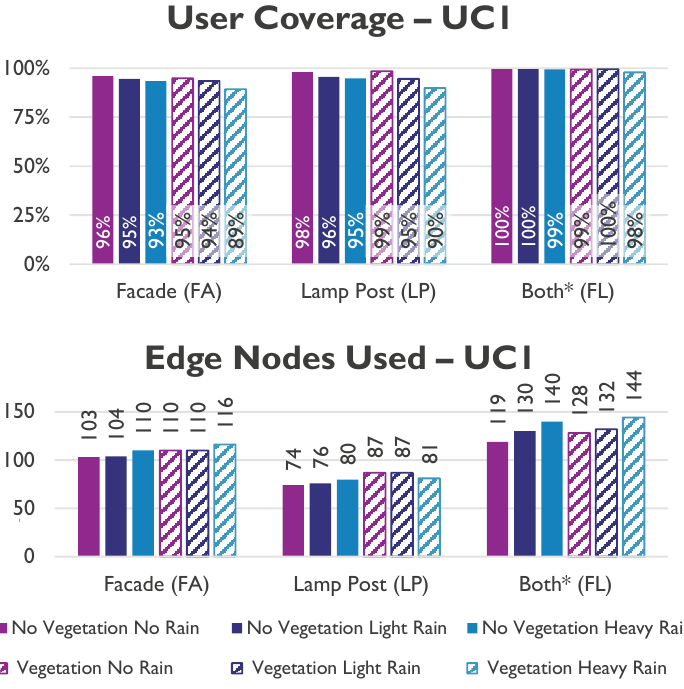
Figure 8. User coverage and network utilisation in UC